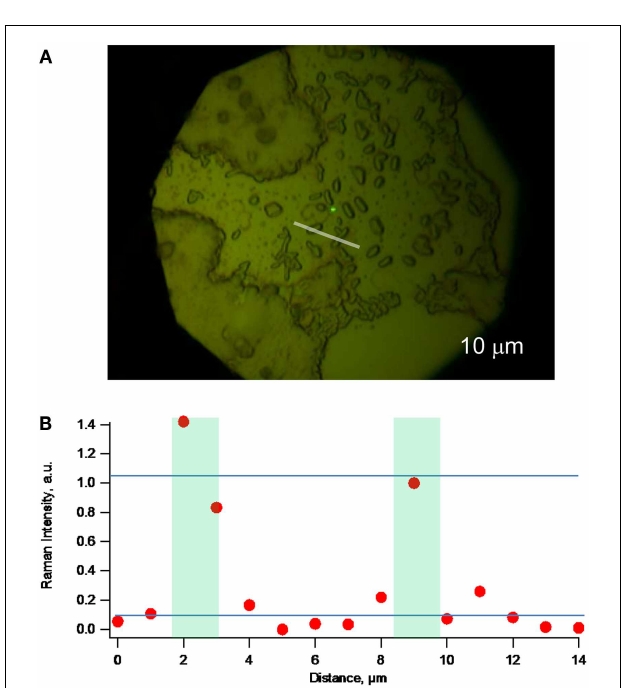
FIGURE 3 | PhaseAFM image of biofilm region containing multiple parallel linear structures at high resolution . (A) Blue dashed rectangle indicates segment of one filament. Blue dashed circle indicates one nodule